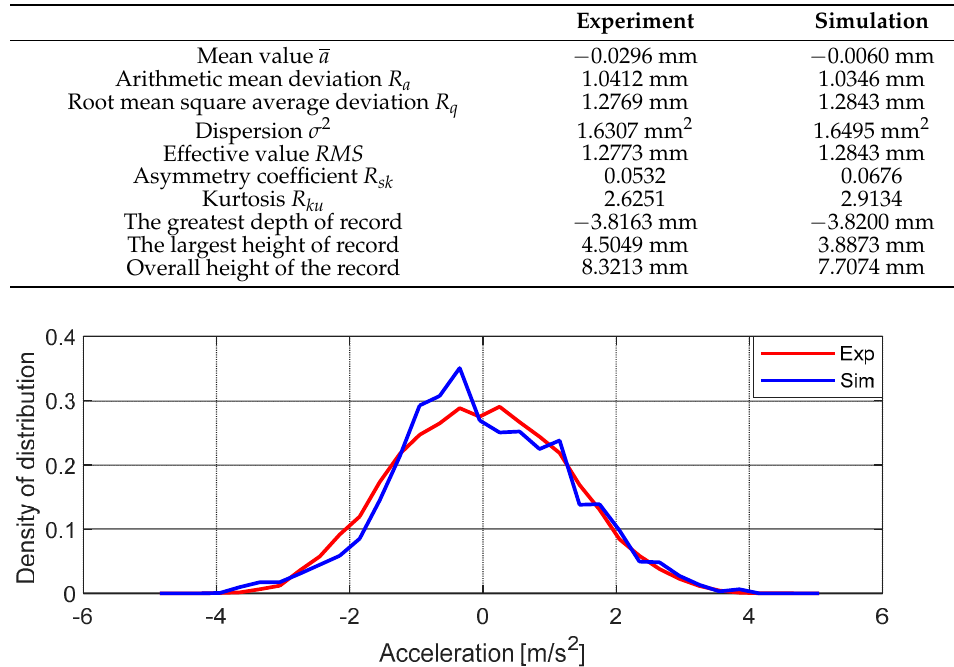
Table 5. Statistical characteristics of acceleration in vehicle CG.